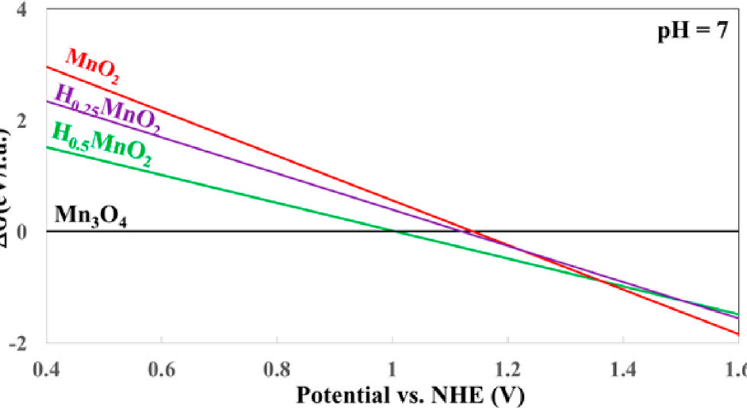
Figure 14. Calculated phase diagram for spinel Mn 3 O 4 , H 0.5 MnO 2 , H 0.25 MnO 2 , and MnO 2 at pH 7. (Reprinted from ref. [60] with permission from American Chemical Society. Copyright © 2018, American Chemical